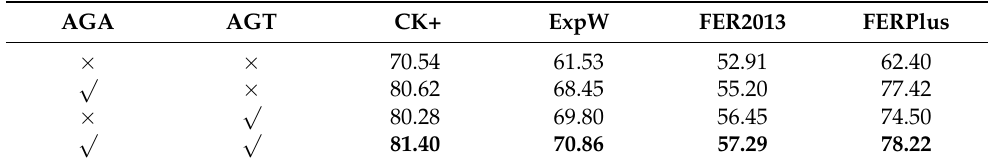
Table 3. Evaluation of AU-guided annotating (AGA) and AU-guided triplet training (AGT) on the CK+, ExpW, FER2013, and FERPlus datasets.